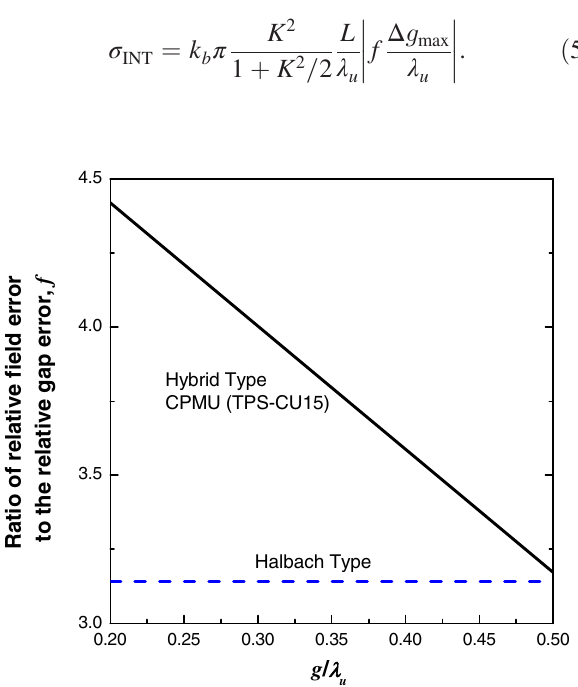
FIG. 6. Dependence of the f value, the ratio of relative field error to the relative gap error, on the relative magnetic gap, g= λ in a CPMU (TPS-CU15).